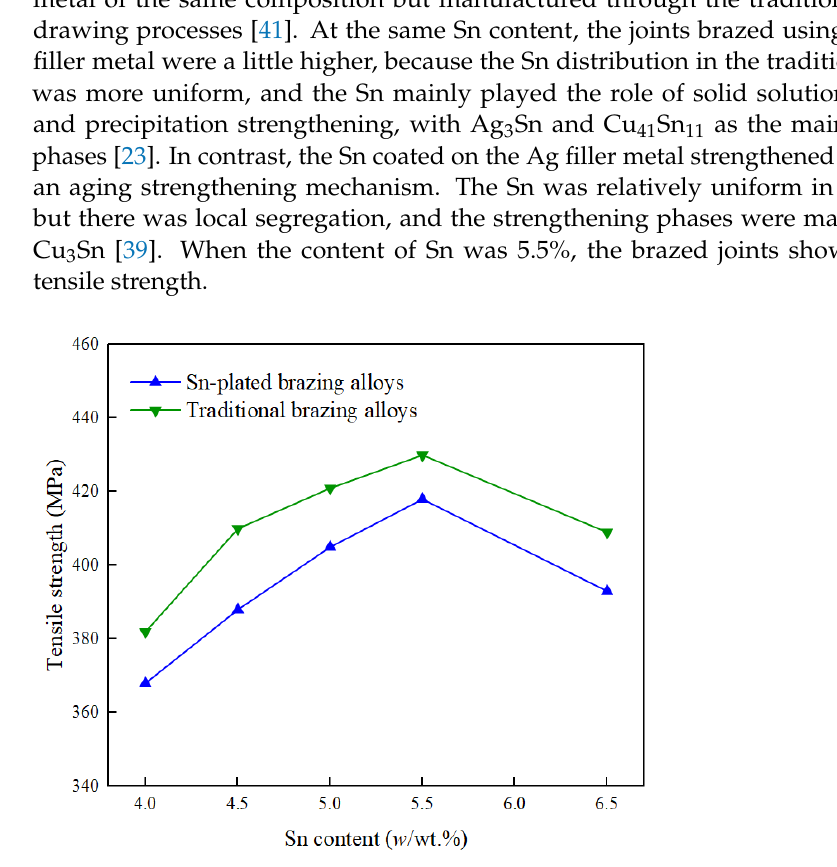
Table 4. Melting temperatures of Cu-5P filler metals with different contents of Sn [45].